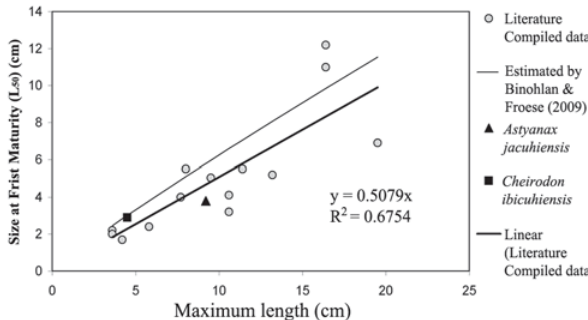
Fig. 3. Relationship between size at first maturity (L maximum reported size for small characids (grey spots, bold line; data from Table 1). The thin line represents L estimated from maximum size following the general function of Froese & Binohlan (2000). Black spots are original data from the present study (SCL values).